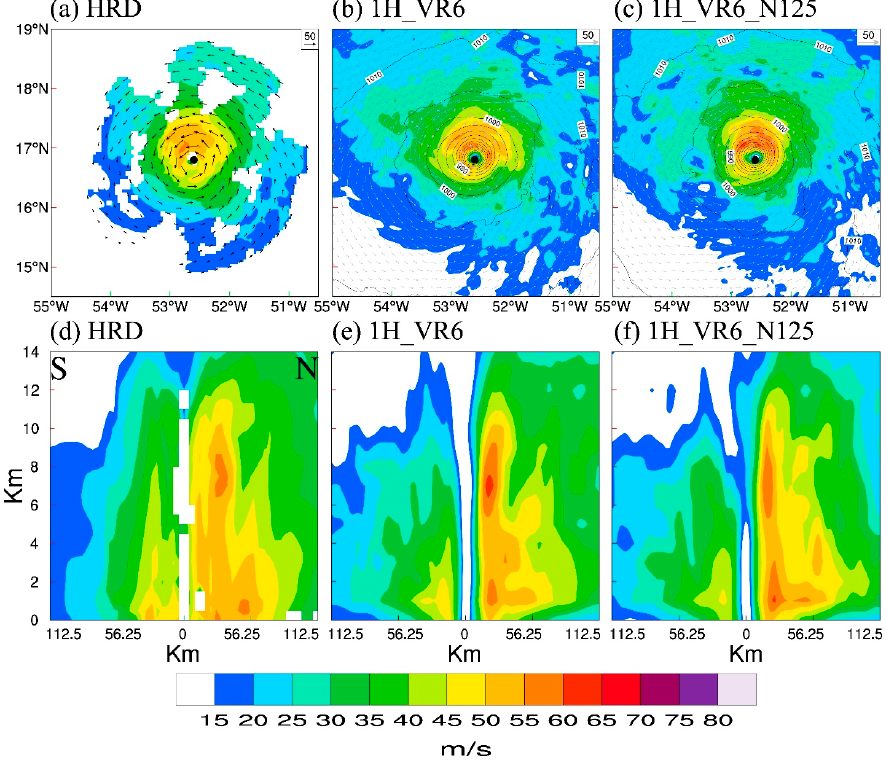
Figure 12. Same as Figure 3, except for ( b , e ) “1H_VR6” and ( c , f ) “1H_VR6_N125”. However, further investigations into the secondary circulations indicate that the in- ner-core AMVs may still be necessary for a rapidly evolving hurricane. For example, Fig- ure 6d indicates that the “1H_VR6” can produce a stronger inner-core structure with higher and stronger upper-level outflow as compared to “1H_VR6_N125” (Figure 6b). This stronger storm analysis is also found multiple times in Figure 11d. Figure 7d shows that the general outflow in “1H_VR6” around this level is stronger than “1H_VR6_N125” (Figure 7e), especially in the southern portion of the storm, where “1H_VR6” produces an outflow that is more consistent with the observations in both strength and directions than